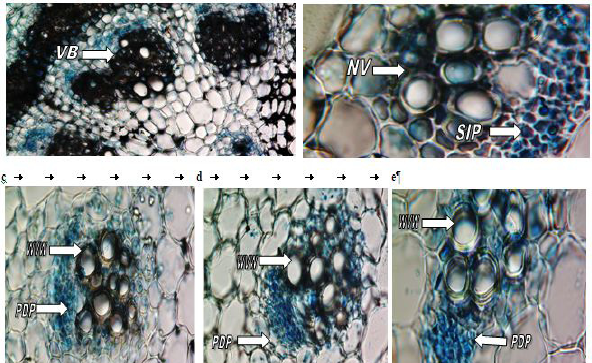
loss of structural integrity of the phloem (LSP). X400